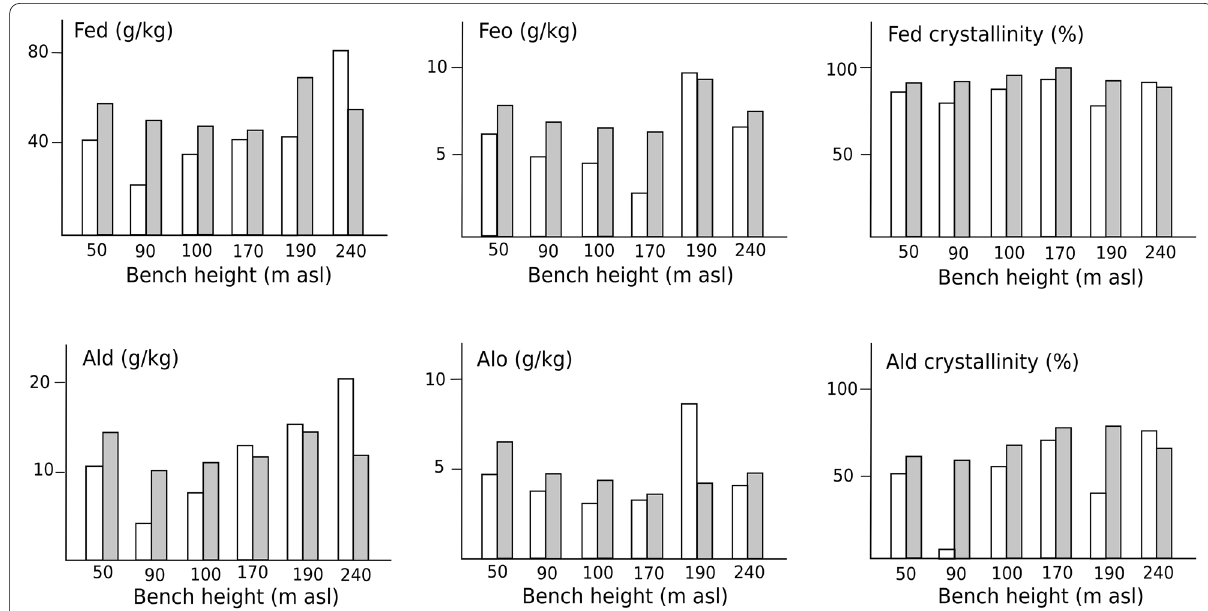
Fig. 2 Sesquioxides (g kg − 1 ) in non‑coral top‑ and sub‑soils in a ferralisation chronosequence on Green Island, Taiwan. Clear bars ‑ topsoil; Shaded bars‑ diagnostic subsoil